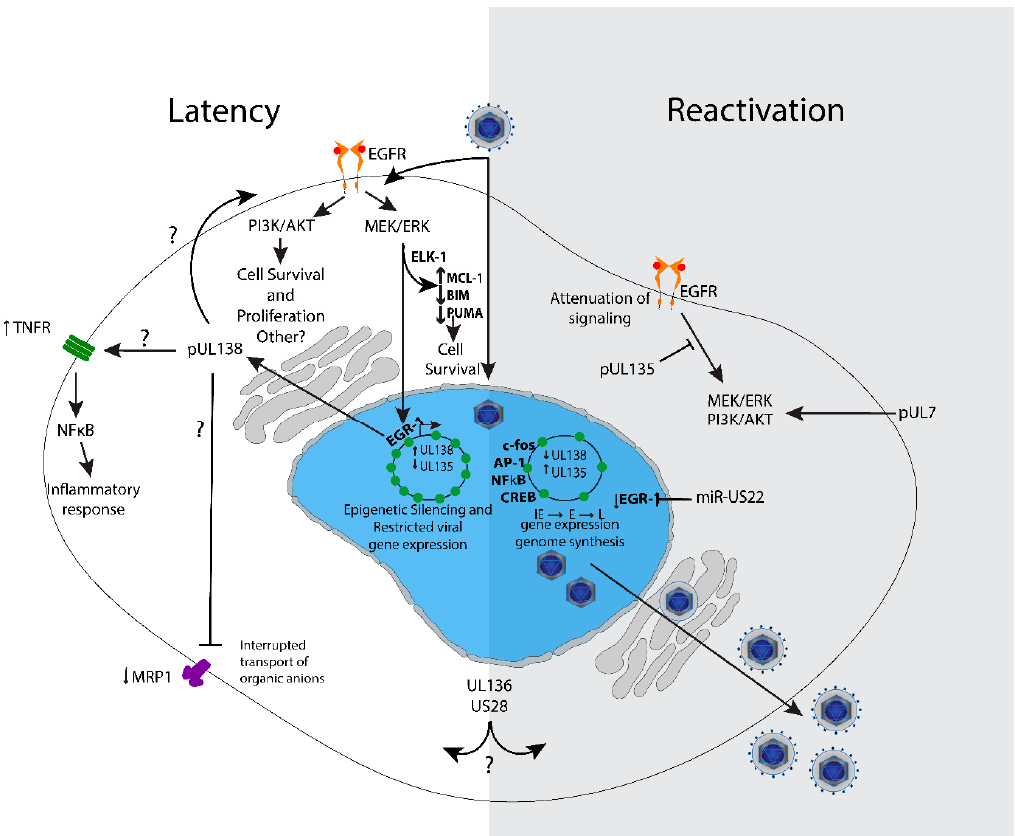
Figure 3. Model of UL133–UL138 virus-host interactions and signaling impacting latency and reactivation. Virus binding and entry stimulates EGFR, PI3K/AKT, and MEK/ERK signaling to set